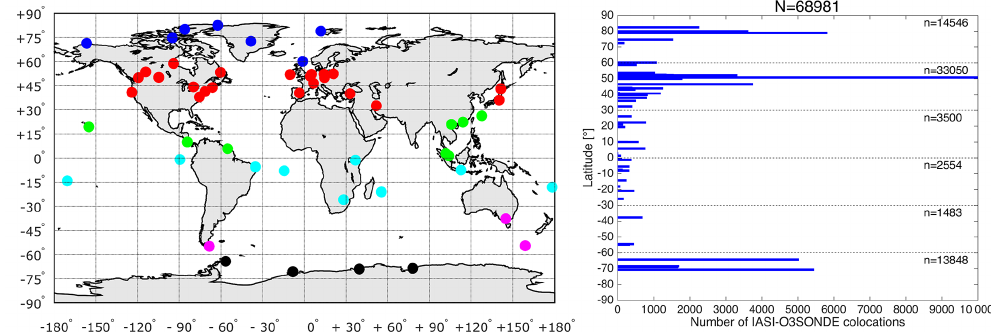
Figure 13. Left: location of the worldwide ozonesonde profiles of WOUDC used in this analysis. The colors indicate different latitude bands: 60–90 ◦ N (blue), 30–60 ◦ N (red), 0–30 ◦ N (green), 0–30 ◦ S (cyan), 30–60 ◦ S (magenta), and 60–90 ◦ S (black). Right: distribution of the amount of IASI-A–ozonesonde coincidences available for this study as a function of latitude. The dashed grey lines indicate the latitude boundaries used in this study to evaluate the IASI biases in more detail: the northern high latitude region is at 60–90 ◦ N, the northern middle latitude region is at 30–60 ◦ N, the northern tropics is at 0–30 ◦ N, and the same symmetrically opposite for the Southern